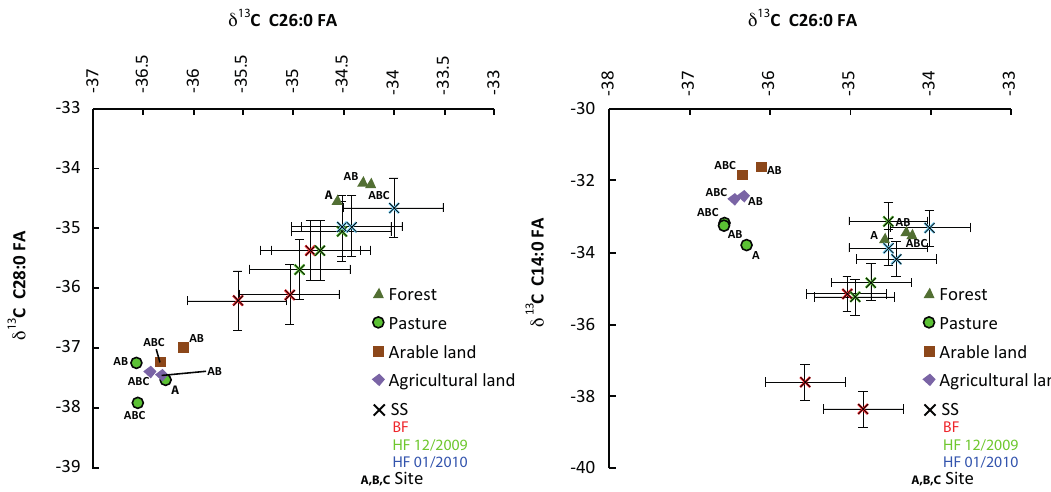
Figure 3. δ 13 C isotopic signatures of FAs C26:0 vs. C28:0 (left) and C26:0 vs. C14:0 (right) of sediment sources and suspended sediments at the three sites (A, B and C) in the Enziwigger catchment. Error bars of SS display the measurement error of 0.5‰. Table 1. Contribution of the different sediment source areas to the suspended sediment, calculated with the different methods and using two or three sources and two FAs as tracers (i.e., C26:0 and C28:0). Values in brackets represent the uncertainty ranges of the estimates. 2 Tracer/2